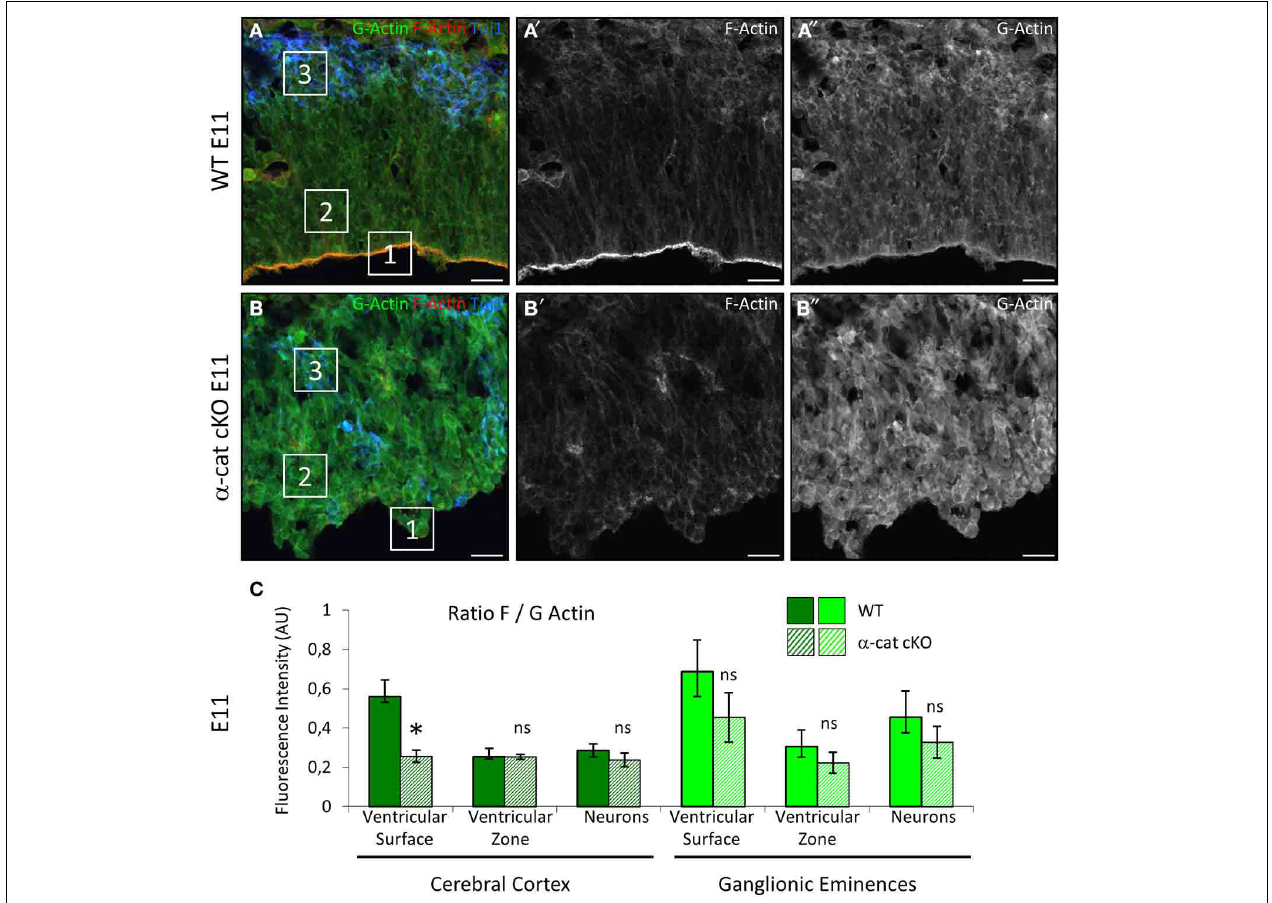
FIGURE 7 | Alterations in in the actin cytoskeleton. Visualization of F- and G-actin in E11 WT and α -cat cKO cortices (A,B) . The ratios of F to G-actin were quantified by confocal microscopy (C) . Squares